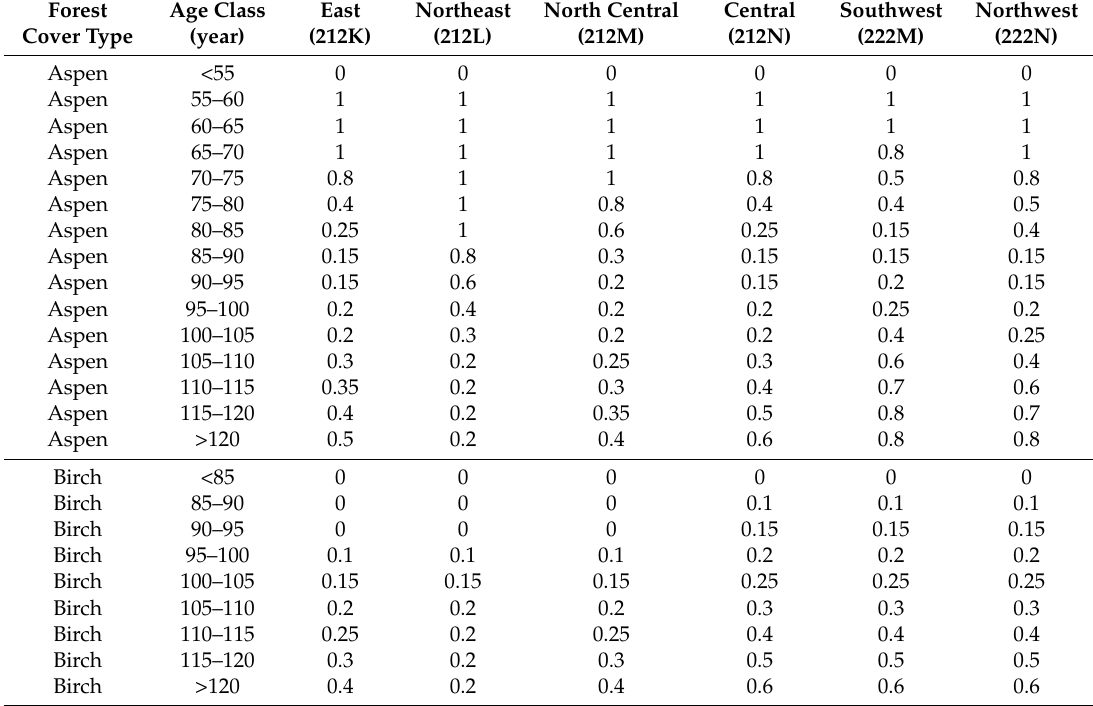
Table 1. Percentages of the area of aspen and paper birch forest cover types that meet old forest requirements in each ecoregion and each stand age